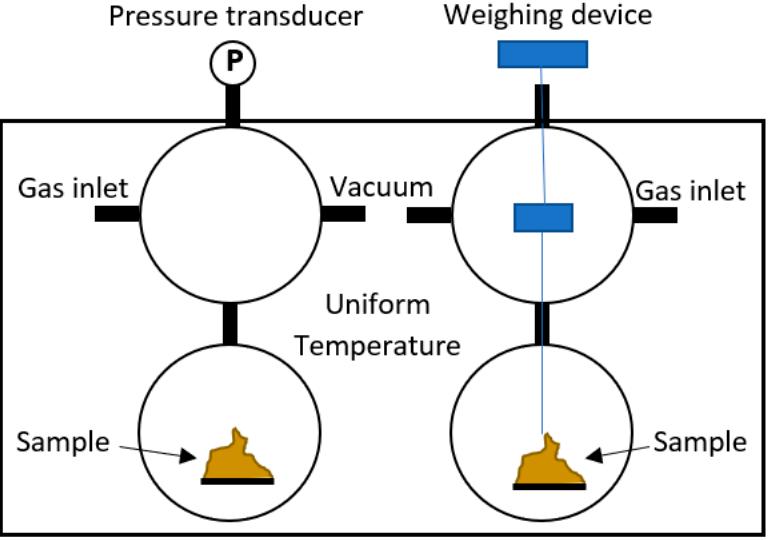
Figure 2. Simplified diagram of the volumetric method ( left ) and the gravimetric method ( right ) to determine the volume of adsorption.